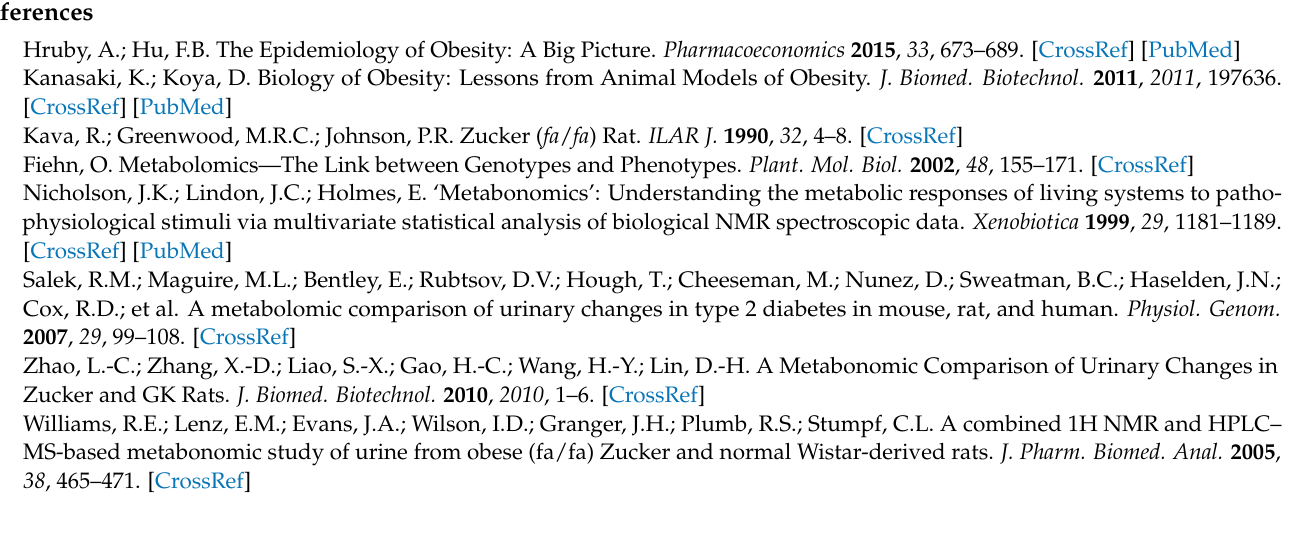
Table S2: The identification of significantly changed metabolites in untargeted LC-MS serum analysis; Figure S3: Score plots of the urine PLS-DA